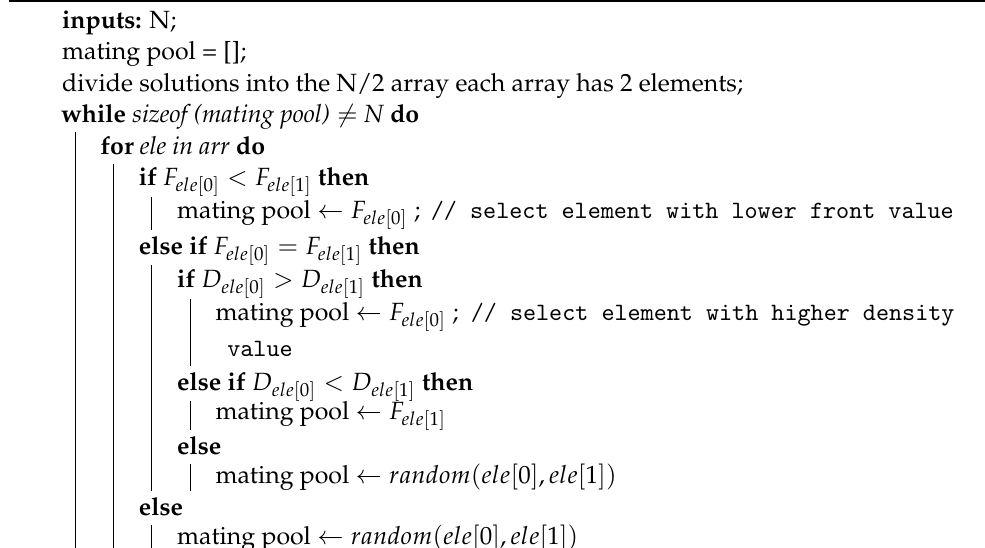
Algorithm 2: Crowded binary tournament selection.